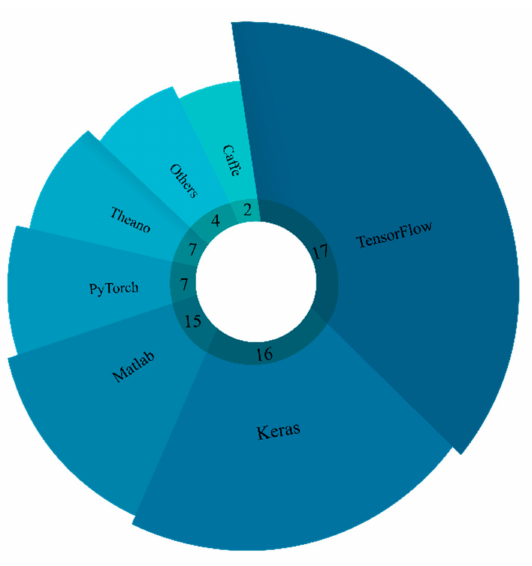
Figure 1. Number of times each DL tool was used for automated detection of epileptic seizure by various studies.